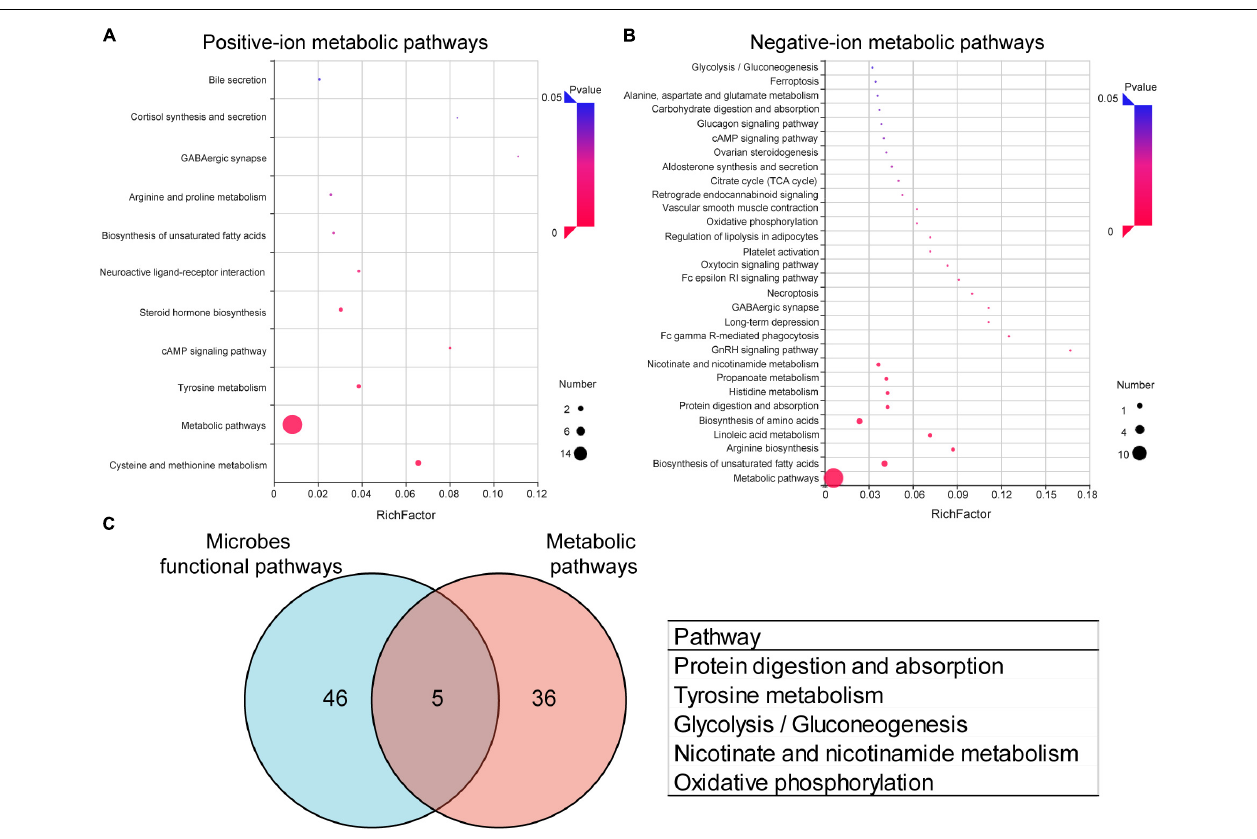
FIGURE 5 | Effects of periodontitis on gut microbe and fecal metabolism. Enrichment of positive-ion metabolic pathways (A) and negative-ion metabolic pathways (B) in EP vs. Control. (C) Venn diagram of differential metabolic enrichment pathway and the predictive differential functional pathway of gut microbes, the table shows the KEGG pathway in common. EP, experimental periodontitis group; Control, healthy control group; pos, positive ions; neg, negative